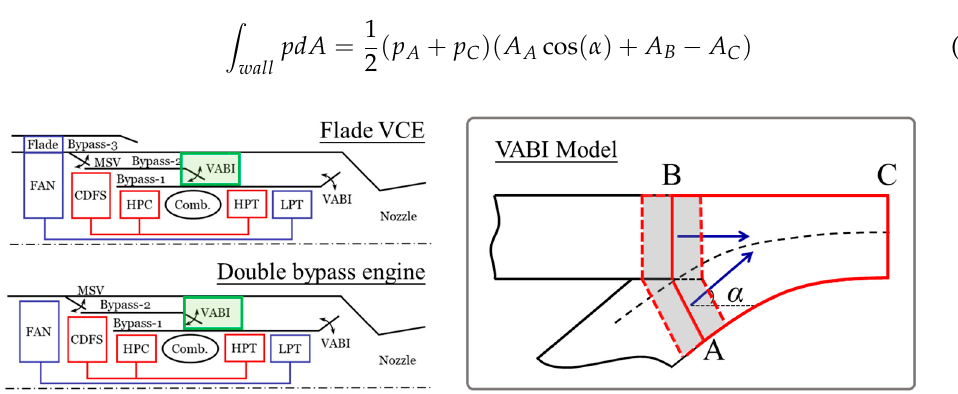
Figure 1. The injection flow in the variable cycle engine and the VABI model (A: inner bypass; B: outer bypass; C: total bypass).